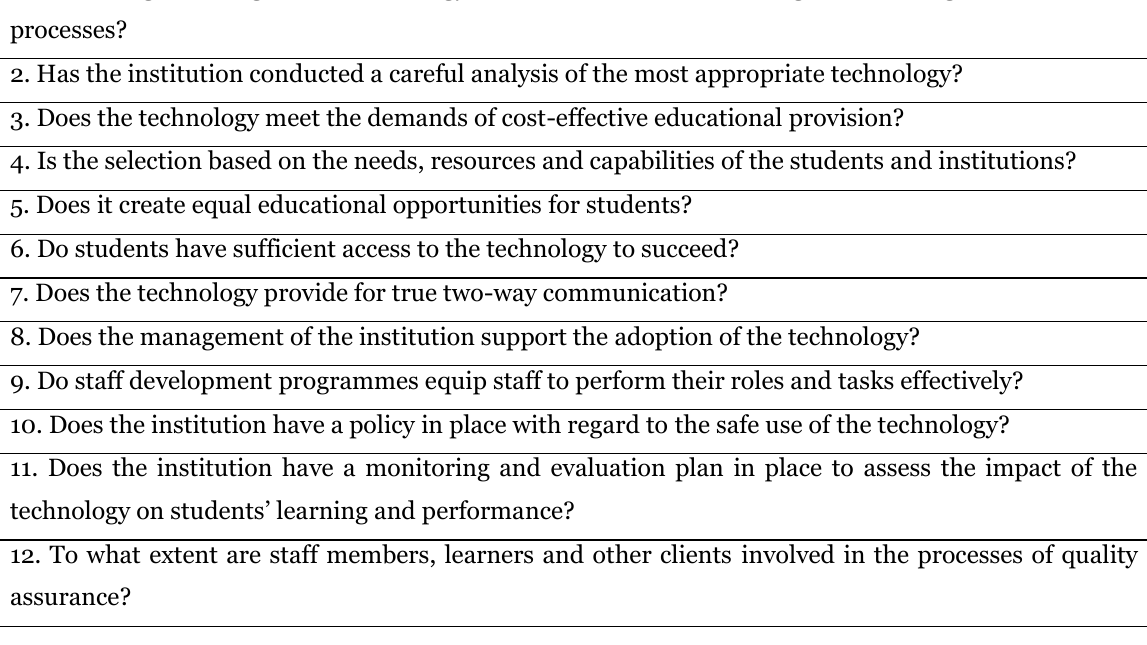
Figure 3. Framework for the Use of Mobile Technology for Teaching and Learning based on the NADEOSA’s quality criteria for designing and delivering distance education identified by Welch and Reed